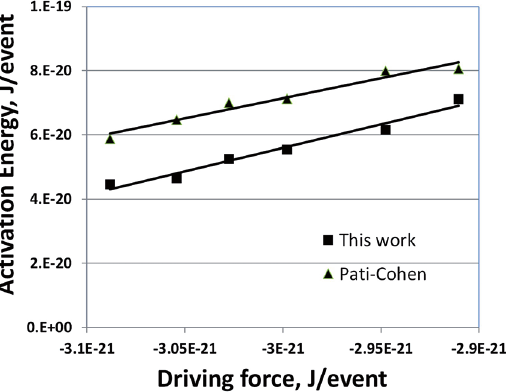
Figure 2: Activation energy of time-dependent martensitic transformation in Fe-24wt%Ni-3wt%Mn alloy as a function of the chemical driving force.